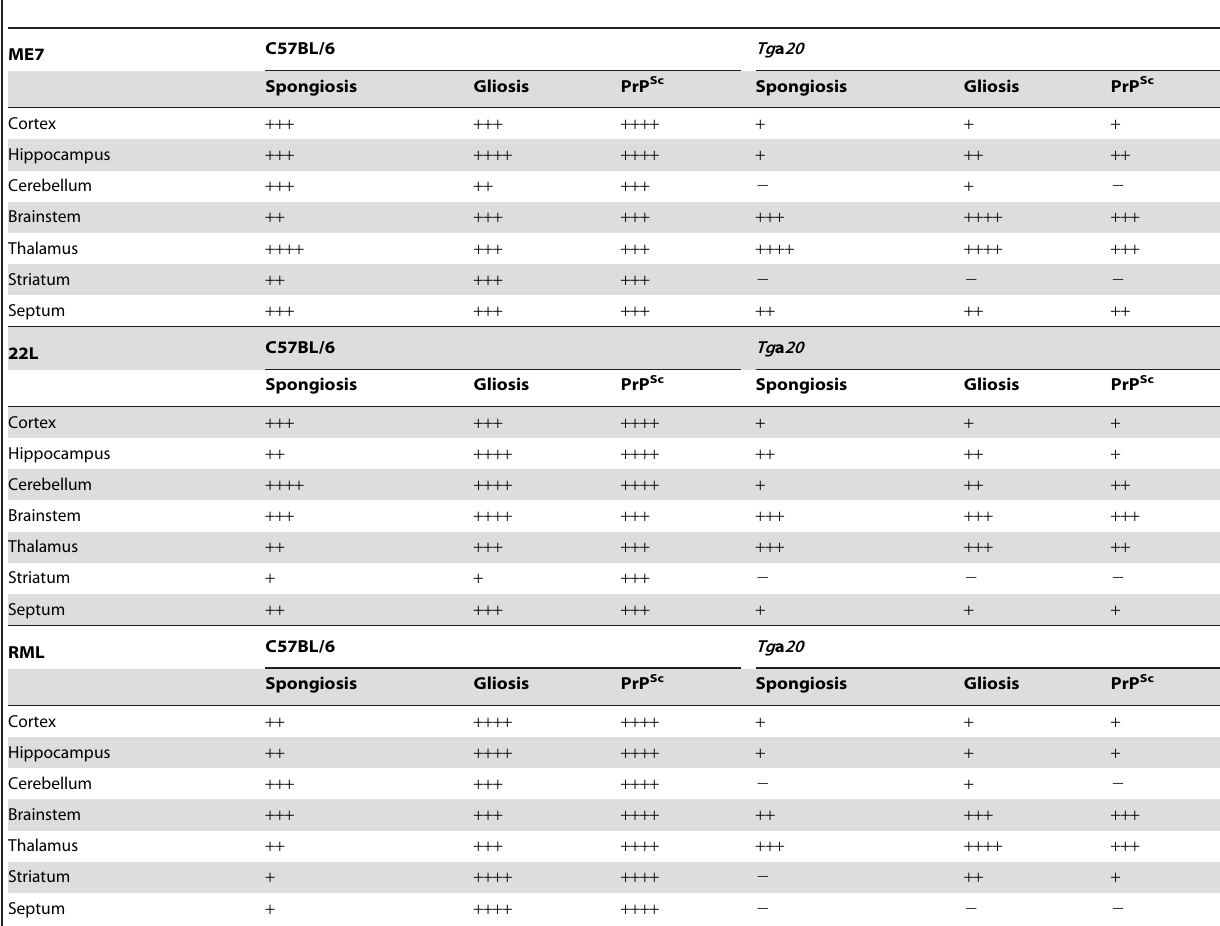
Table 5. Comparative neuropathology in Tg a 20 and C57BL/6 mice infected with three prion strains.